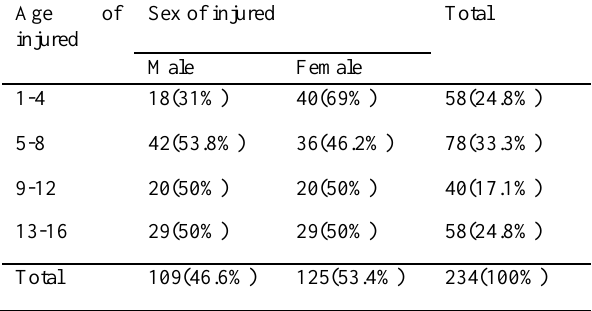
Table 1: Distribution of injured children by age and sex,